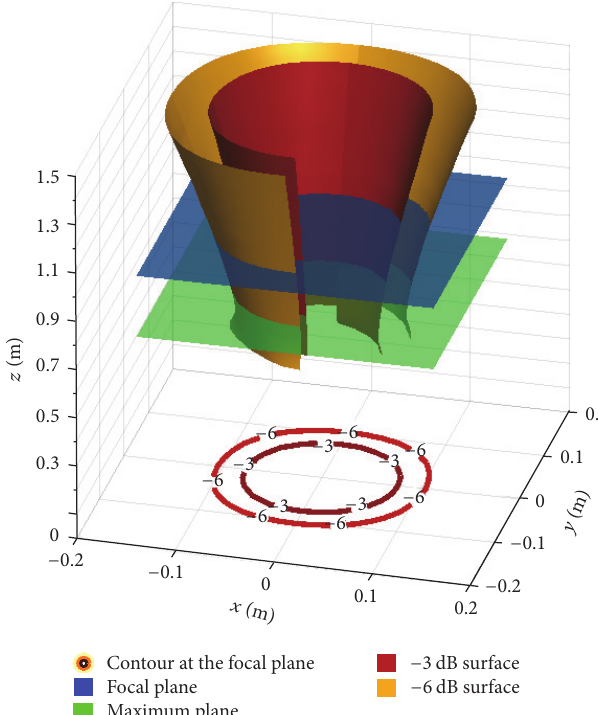
Figure 1: Focused beam of the field radiated by an 8×8 NFF planar array of circularly polarized patches: isosurfaces at − 3dB and − 6 dB. The − 3 dB and − 6dB focal spots at the focal plane have been added, in the horizontal plane of the plot. The array is located at the 𝑥𝑦 surface of the reference system. The focal plane and the maximum field amplitude plane are at around 1m and 77.5 cm from the array surface, respectively.